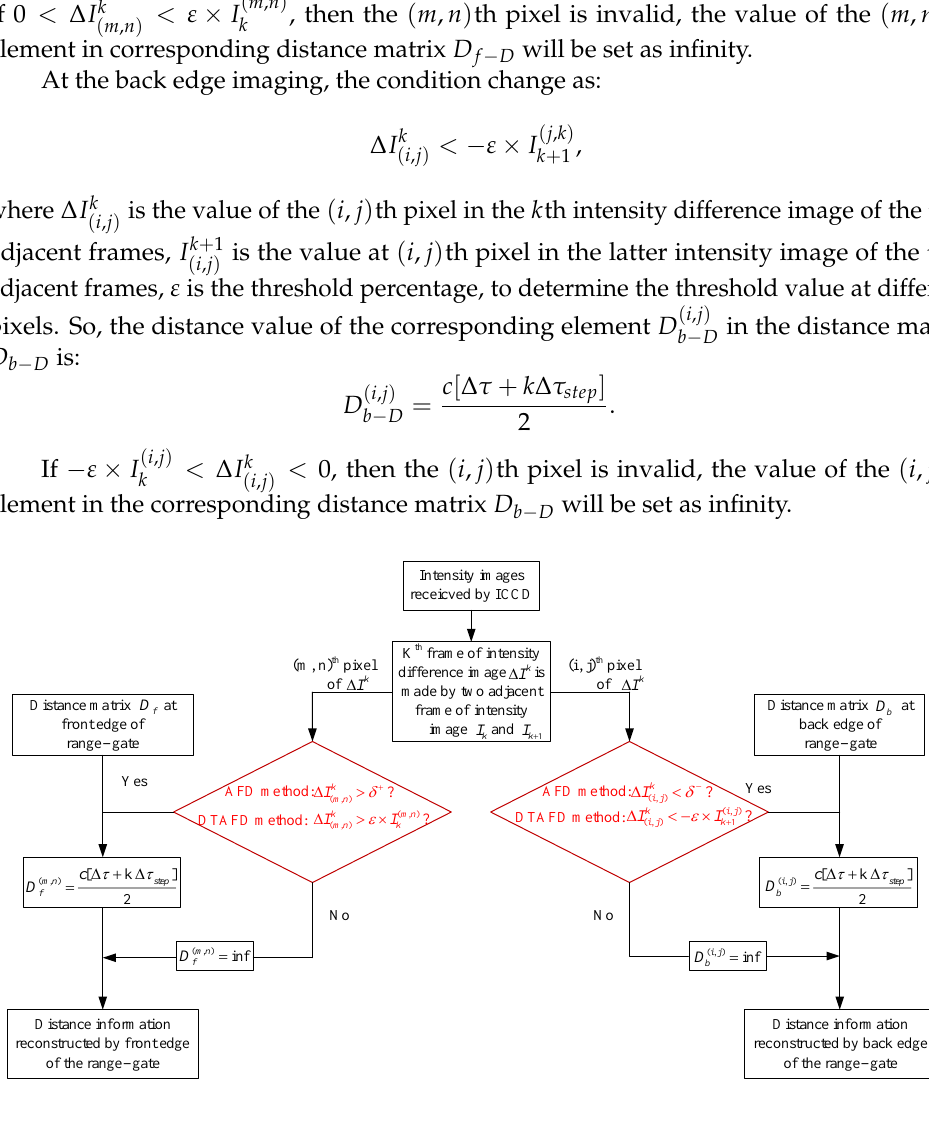
Figure 1. Block Diagram of constant threshold AFD and DTAFD method. The determination of pixel validity is based on the δ in the AFD method. In DTAFD method, the determination of pixel validity is based on the ε